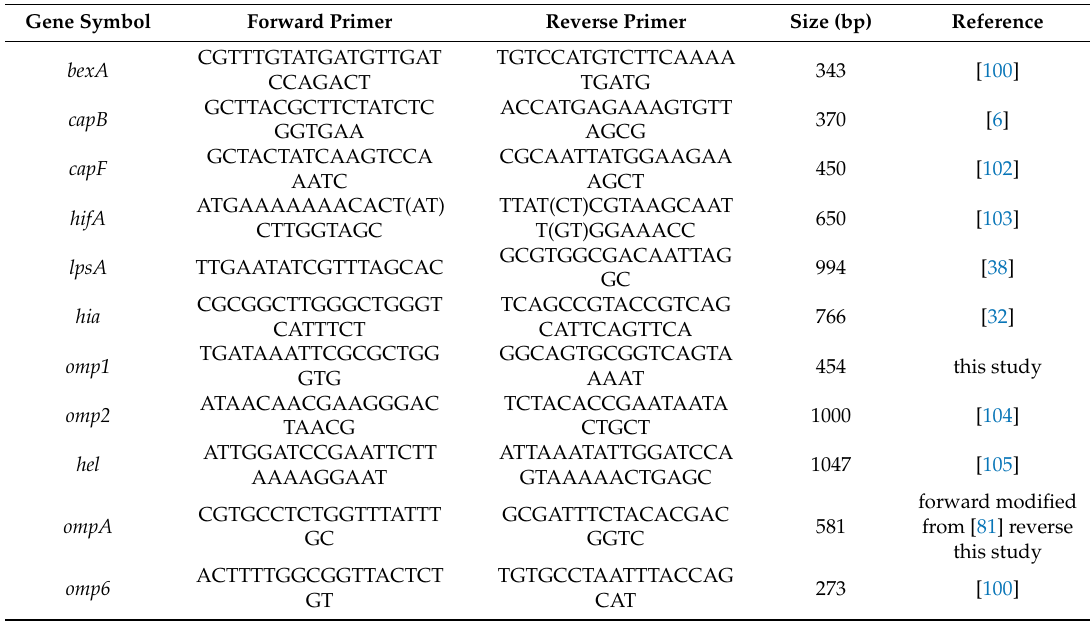
Table 1. Oligonucleotides used for verification of bacterial